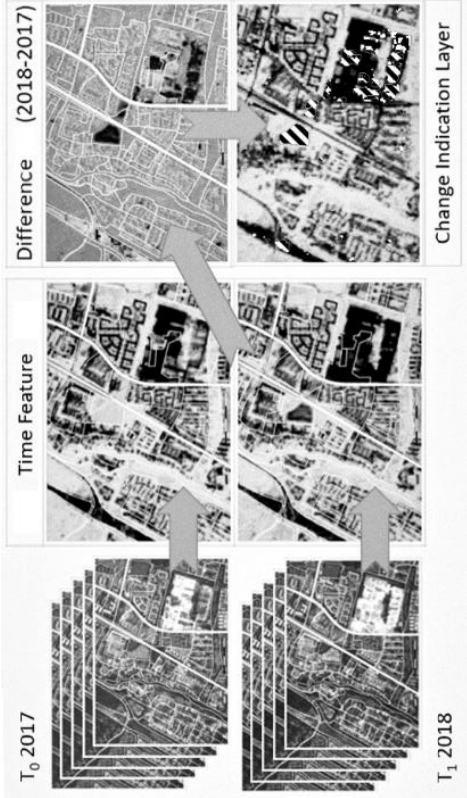
Figure 3 . Production of the change indication